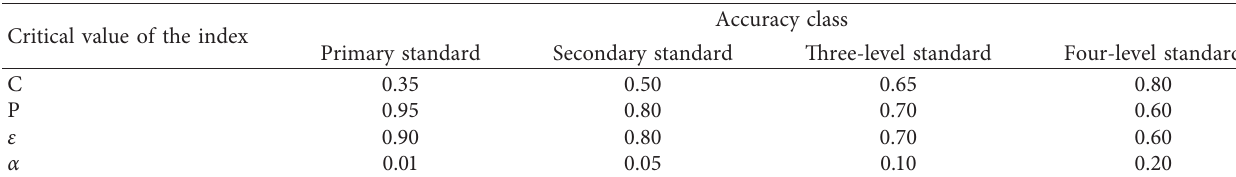
Table 8: Model established index critical